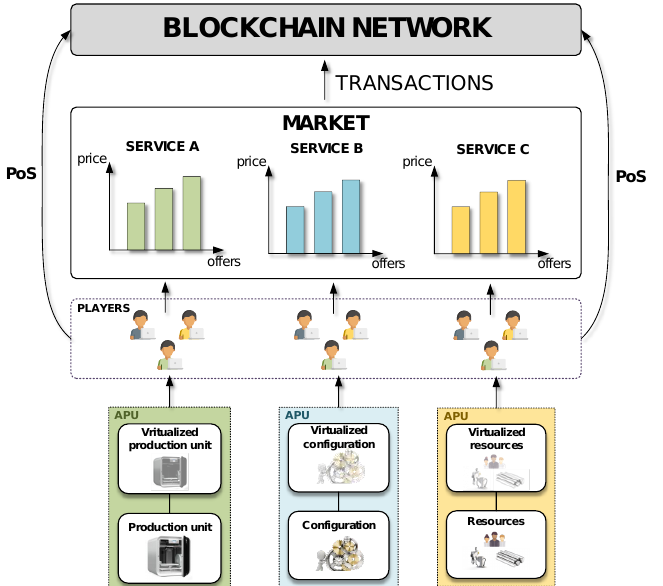
Figure 2. Online game implementation of BBSM